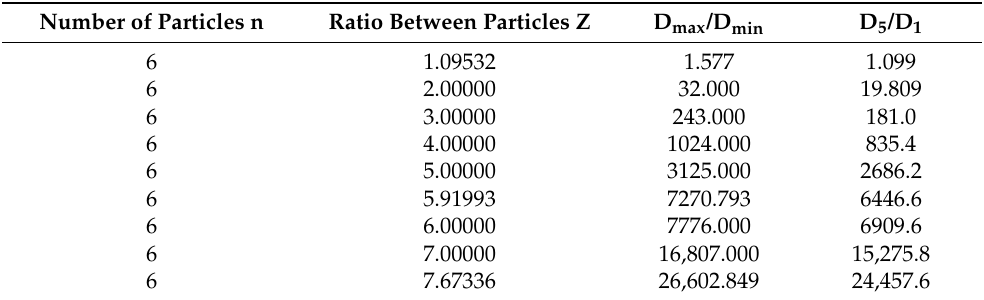
Table 9. Estimated limits of the ratio of the maximum diameter/minimum diameter particles in a particle size distribution.